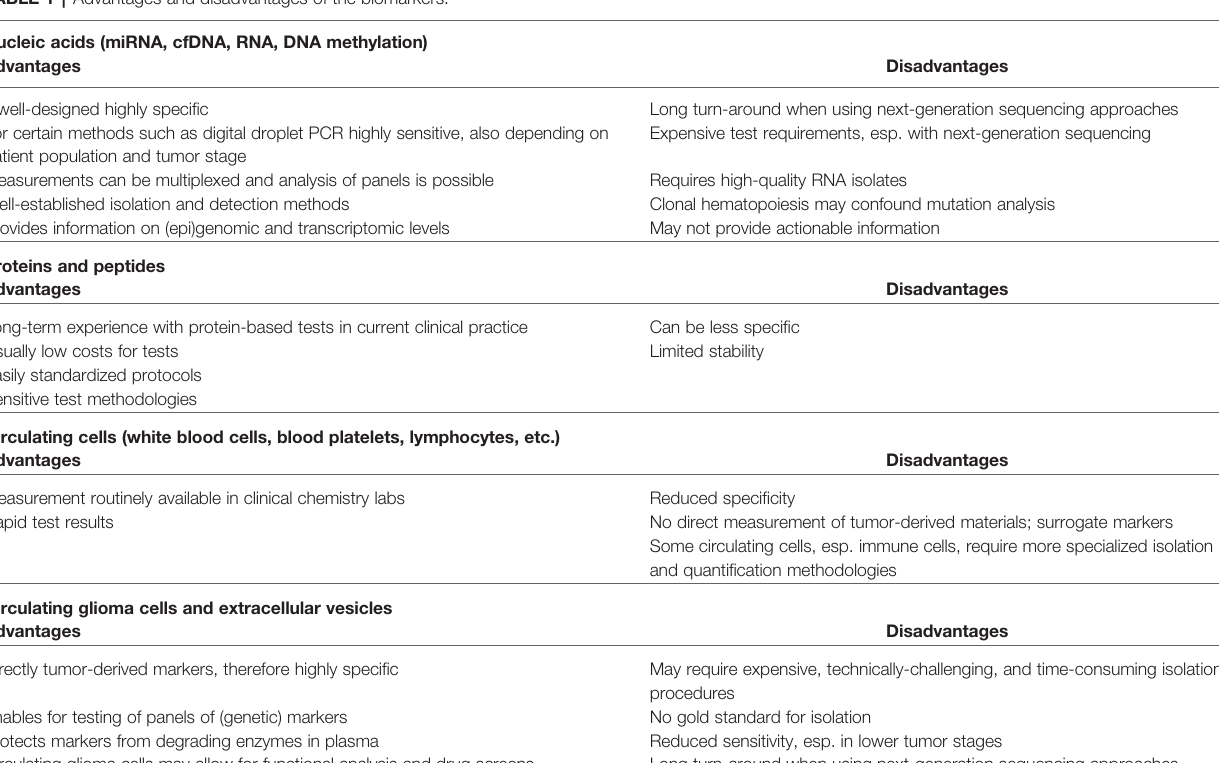
TABLE 1 | Advantages and disadvantages of the